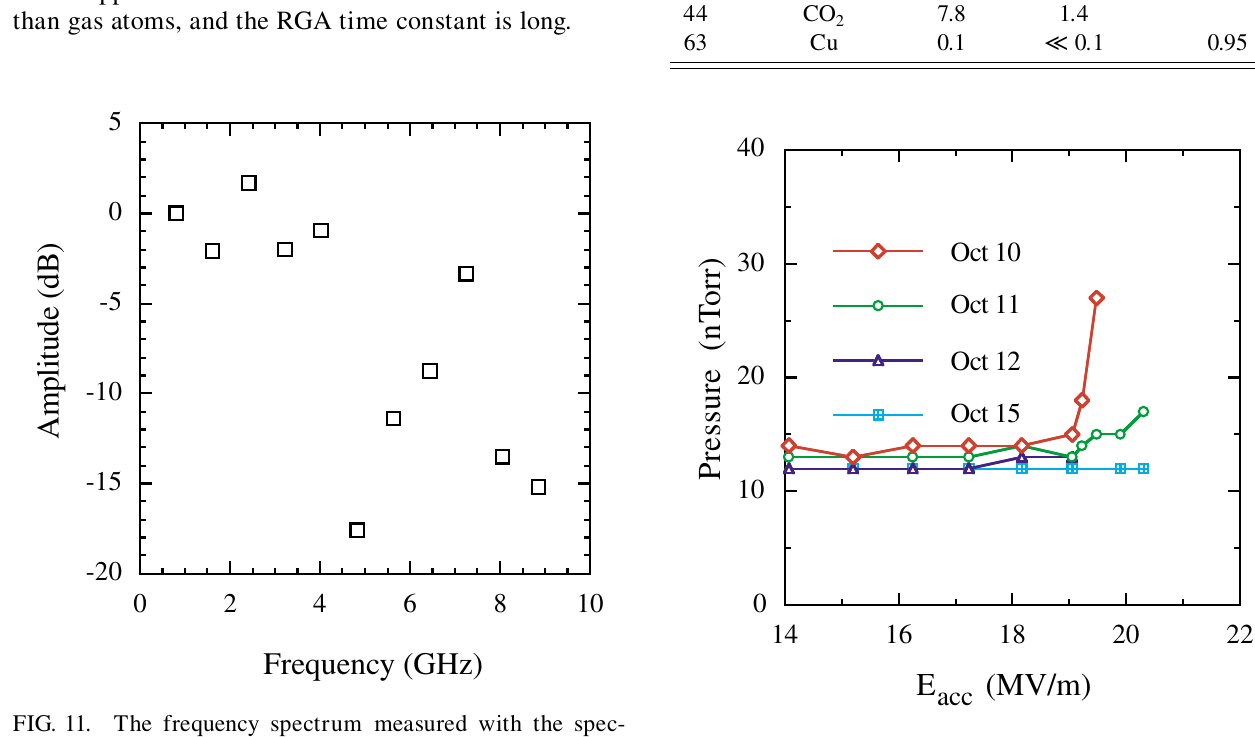
FIG. 13. (Color) Pressure as a function of accelerating field.